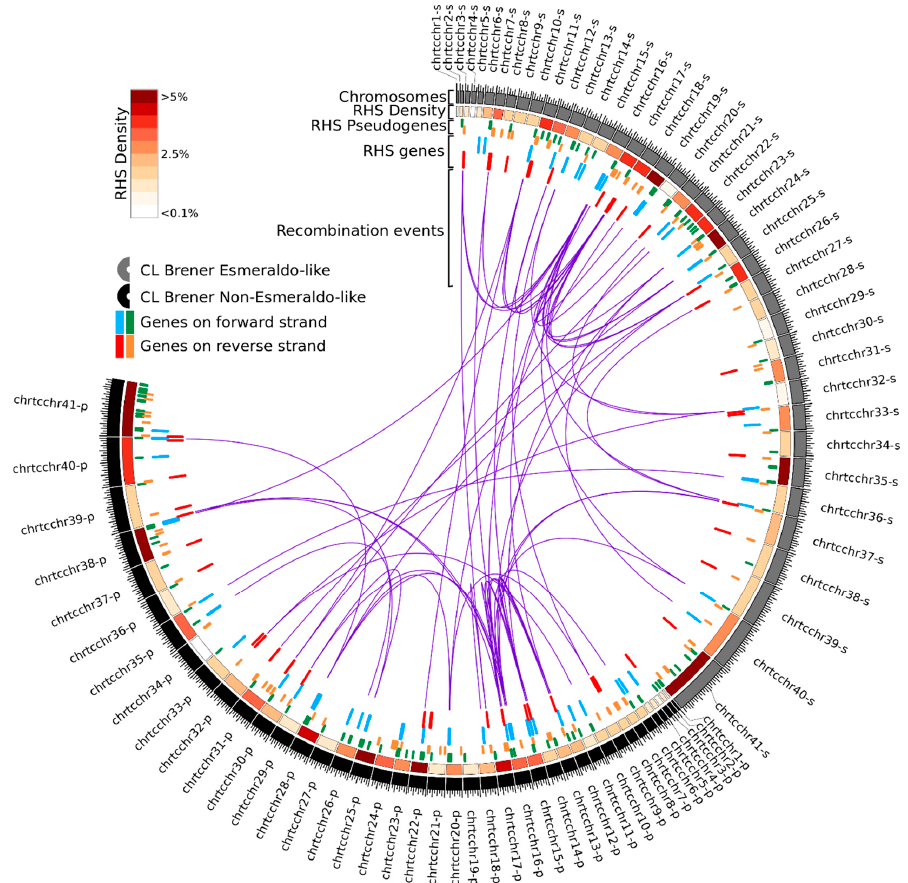
Figure 1. Circos diagram depicting the genomic organization and recombination events of the RHS family in the whole genome of T. cruzi clone CLB. Inner track 1 represents the recombination between RHS genes. The recombinant sequences are linked to putative major and minor parental, using purple and green lines, respectively. Track 2 shows the genomic organization of RHS genes in chromosomes. Genes on forward and reverse strands are colored in blue and red, respectively. Track 3 shows the genomic organization of RHS pseudogenes in chromosomes. Pseudogenes on forward and reverse strands are colored in green and orange, respectively. Track 4 depicts a heat map of RHS genes’ and pseudogenes’ density for each chromosome. Values were obtained by summing the length (bp) of RHS genes and pseudogenes and were divided by the chromosome size. Outer track 5 shows the representation of T. cruzi CLB chromosomes for Esmeraldo (haplotype S) and non-Esmeraldo (haplotype P) allelic loci.